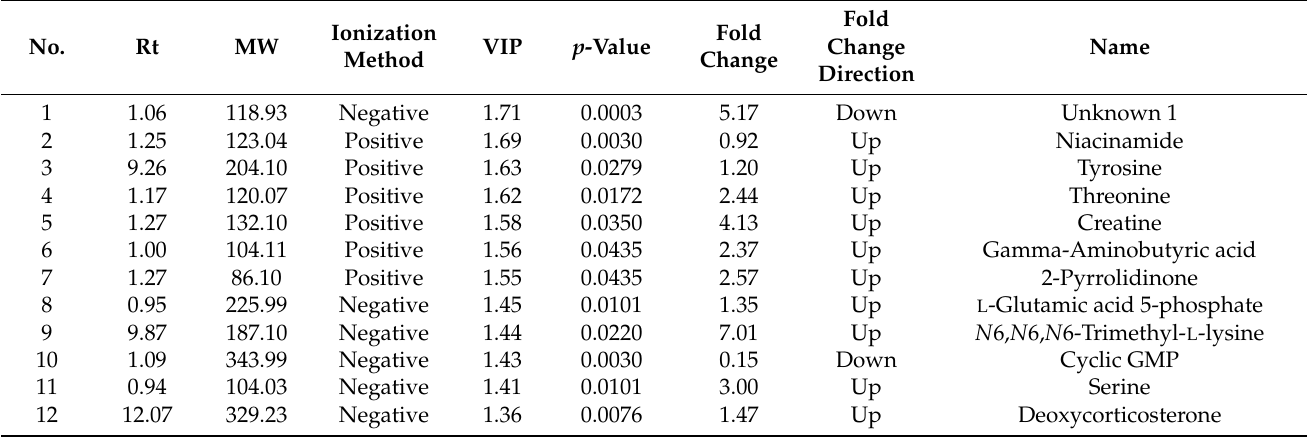
Table 1. The summary of putatively identified significant metabolites.